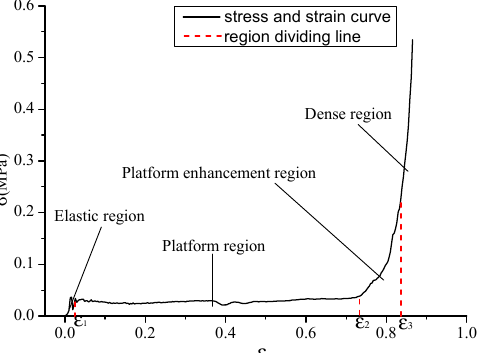
Figure 11. Nominal stress–strain curve of specimen under in-plane impact.